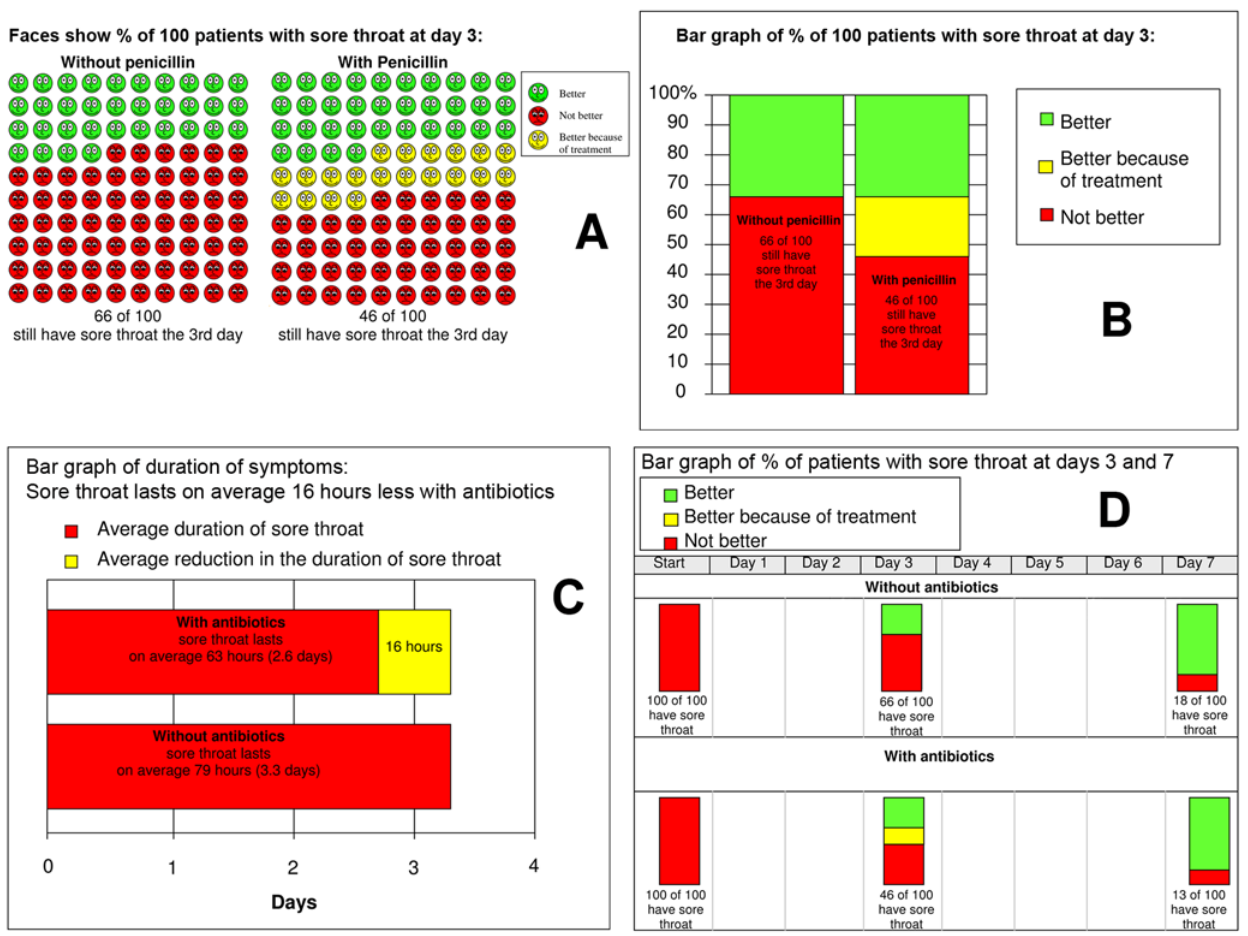
Figure 1. Presentations of benefits of antibiotics for sore throat. Based on a systematic review by Del Mar and colleagues [4] of antibiotic versus placebo for patients presenting for primary care with symptoms of sore throat.